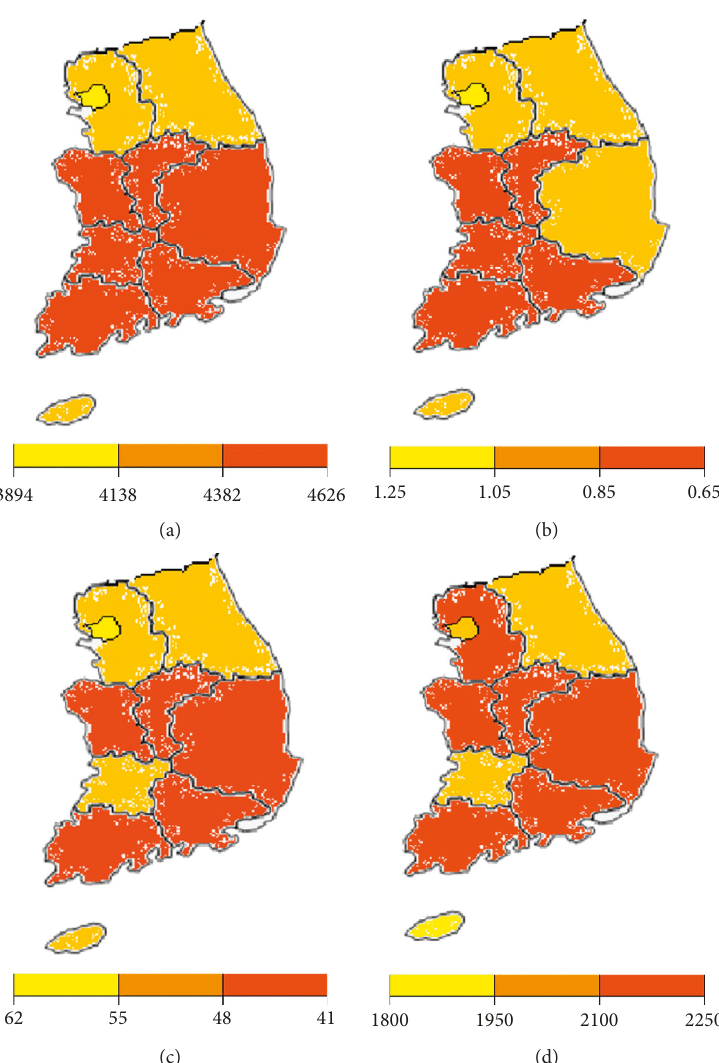
Figure 2: (a) Annual solar radiation, (b) mean spherical equivalent, (c) myopia prevalence, and (d) annual sunshine duration have similar a distribution pattern in South Korea.